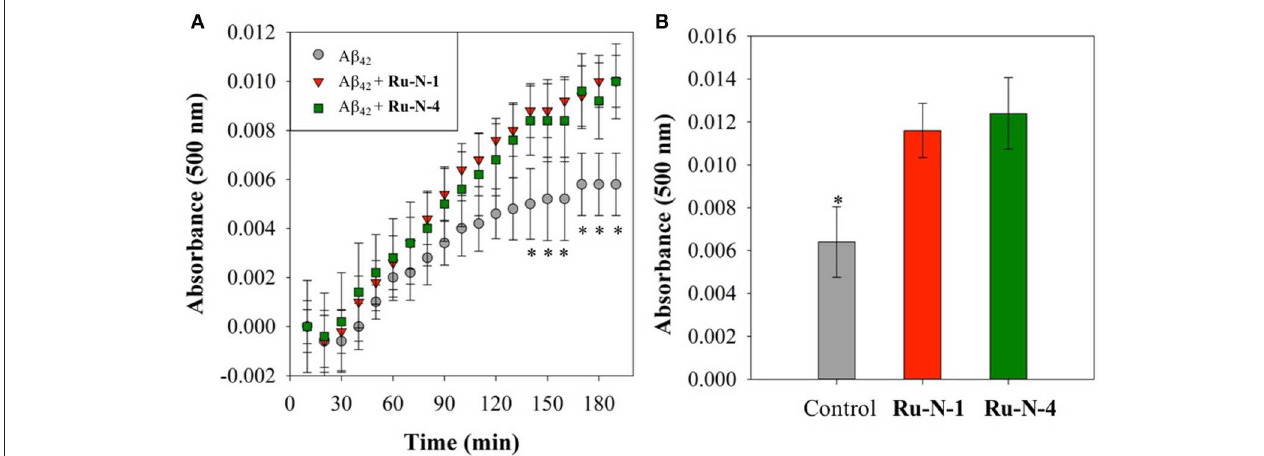
FIGURE 6 | Turbidity assay data from 10 µ M A β 1 − 42 (gray) and with 1 eq. of Ru-N-1 (red) or Ru-N-4 (green) in PBS buffer (0.01M, pH 7.4) with agitation at 37 ◦ C. (A) Change in absorbance during initial 3h of incubation. (B) Change in absorbance at 20h of incubation. *Statistically significant difference between A β 1 − 42 only and in the presence of the complexes, p < 0.05 for (A) and p = 0.01 for (B) . Calculated using JMP13 (Wilcoxon